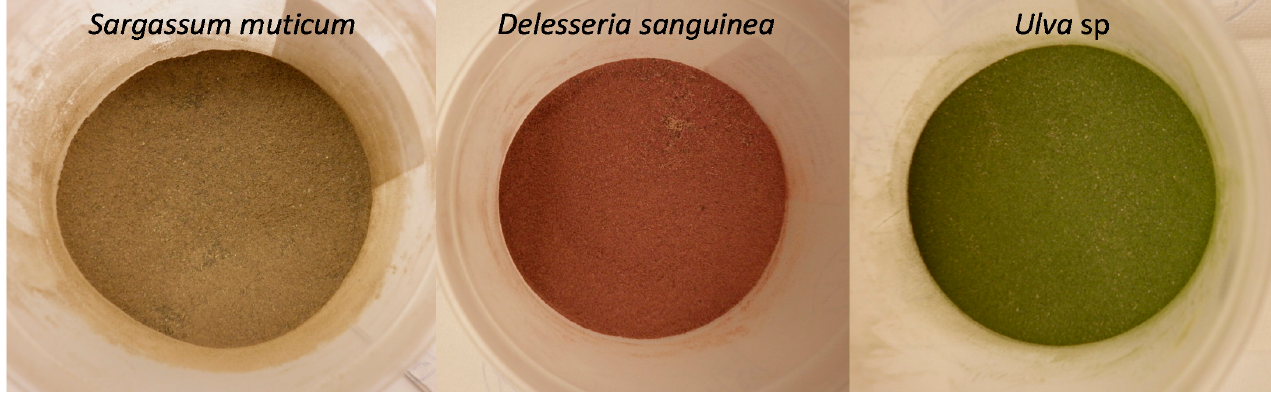
Figure 6. Examples of milled seaweeds. Brown: Sargassum muticum, red: Delesseria sanguinea and green: Ulva sp. seaweeds were milled to pass through a 1-mm screen and homogenized. Table 2. Overview of seaweed species used in the analyses. The eighteen species included red, green and brown species harvested in Nordic waters or in Australia from either wild harvesting of natural populations or from kelp species cultivated on longline systems in the Faroe Islands.